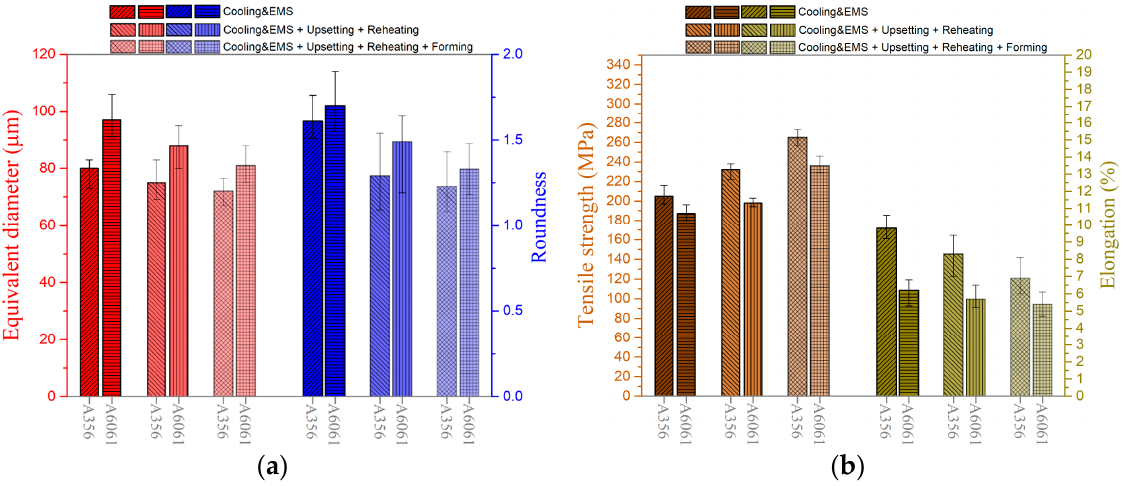
Figure 9. Comparison of characteristic according to process: ( a ) equivalent diameter and roundness of primary α -Al grains; ( b ) tensile strength and elongation.